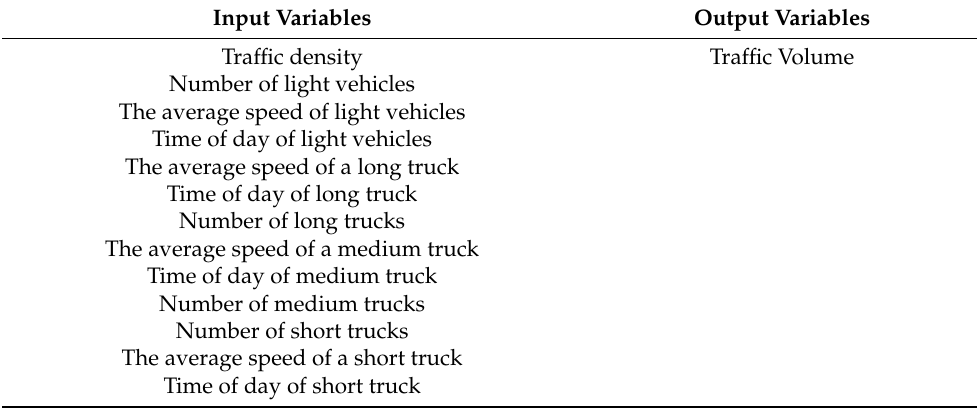
Figure 3. An illustrative description of the N1 (the red line) route through the South Africa Road transportation network. Traffic density: This is the number of vehicles per unit length. It is calculated as: Table 2. Categorization of the traffic datasets into inputs and